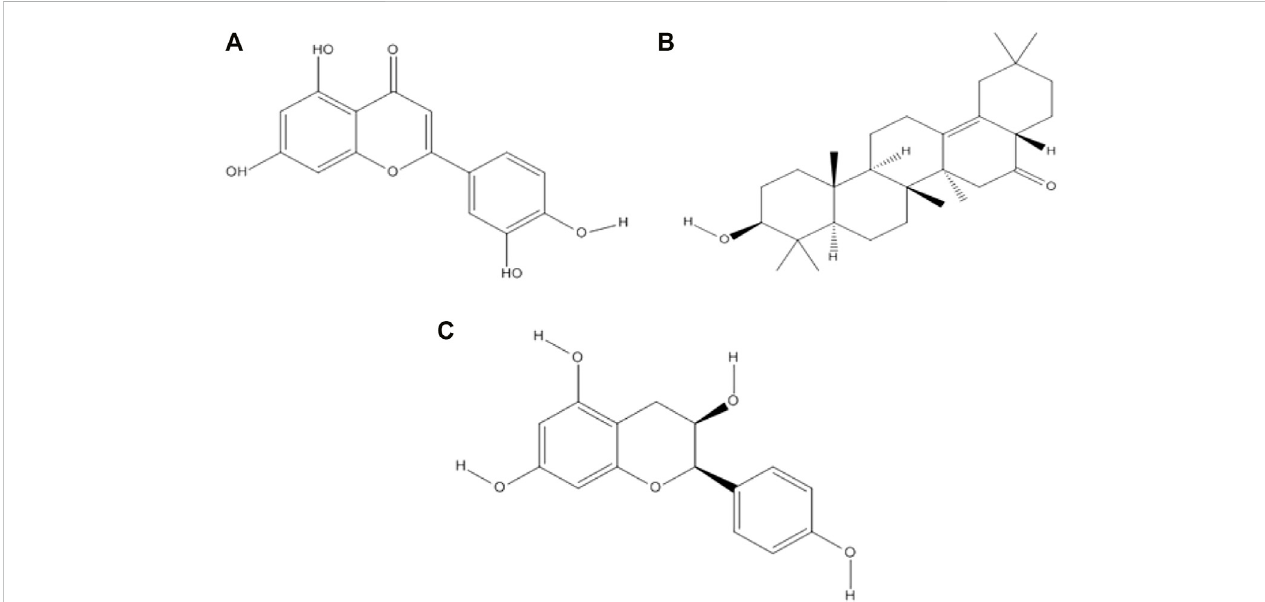
FIGURE 2 Two-dimensional structures of three selected phytocompounds. (A) Luteolin, (B) albigenin, and (C) epiafzelechin.